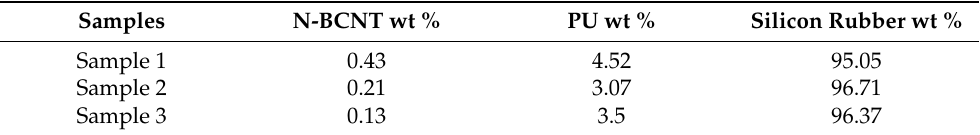
Table 1. Ratios of silicone rubber, PU, and N-BCNT in the prepared N-BCNT/PU-silicone rubber